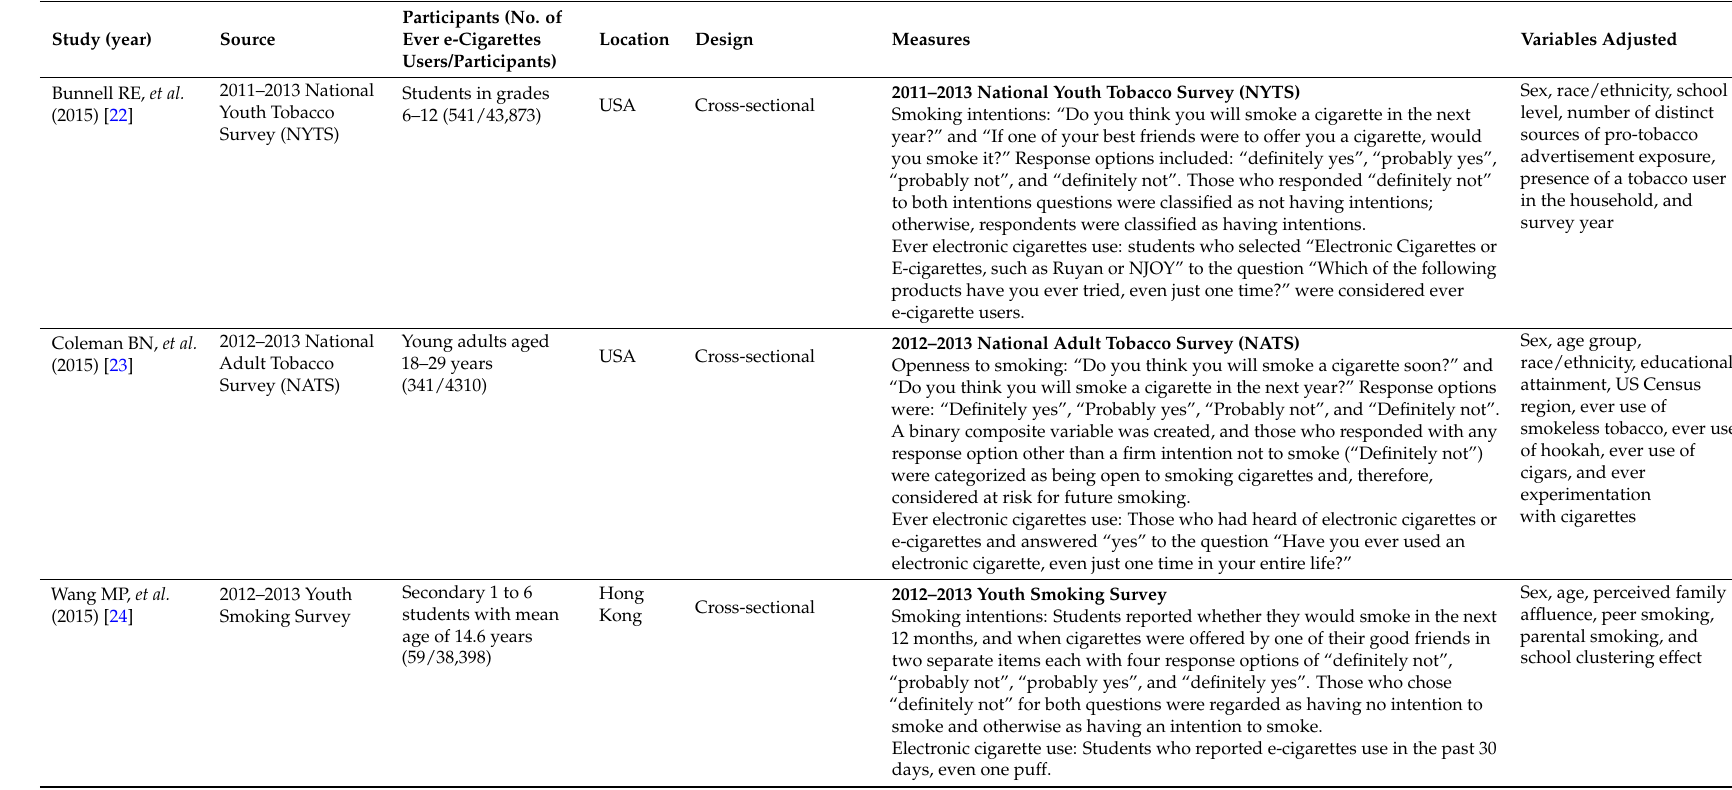
Table 1. Information of the studies included in the